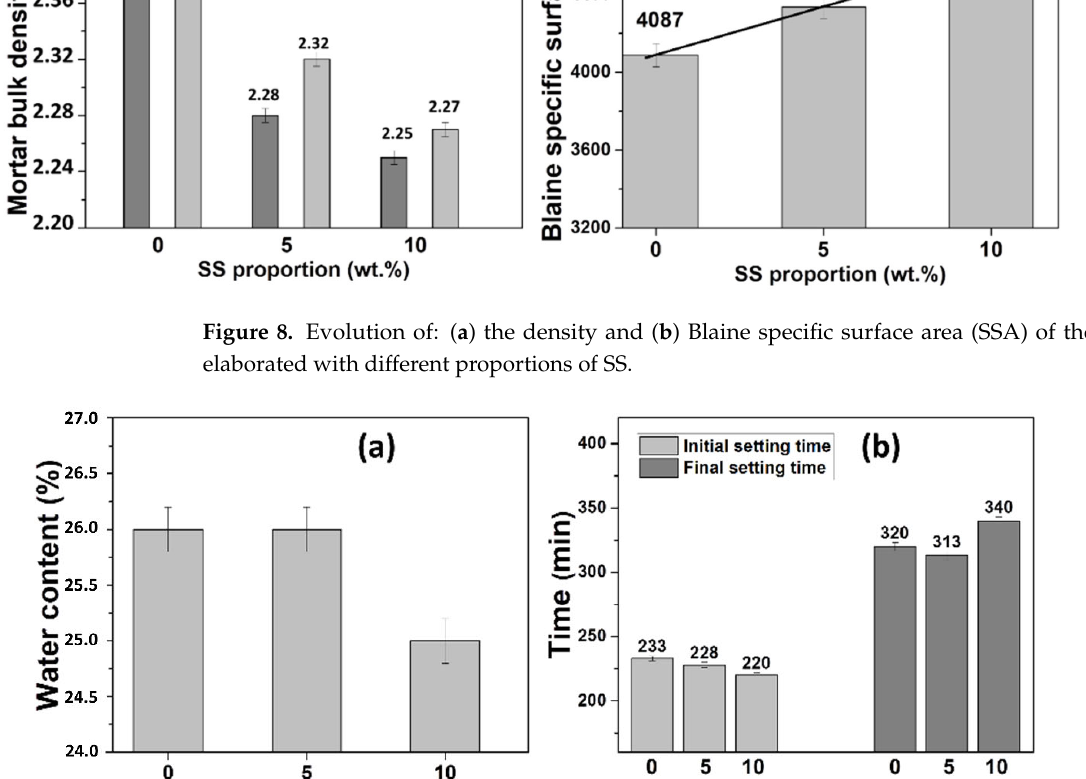
Figure 8. Evolution of: ( a ) the density and ( b ) Blaine specific surface area (SSA) of the cements elab ‐ orated with different proportions of SS .